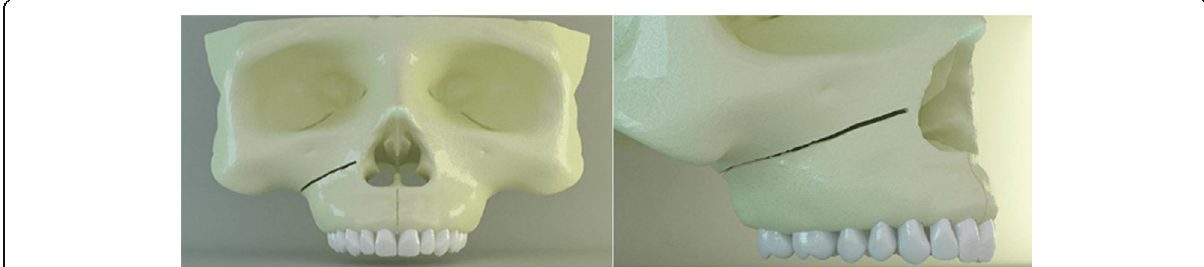
Fig. 2 Oblique corticotomy line from frontal and lateral view. The line extends from apertura piriformis to pterygopalatinal junction lying beneath the zygomatic buttress